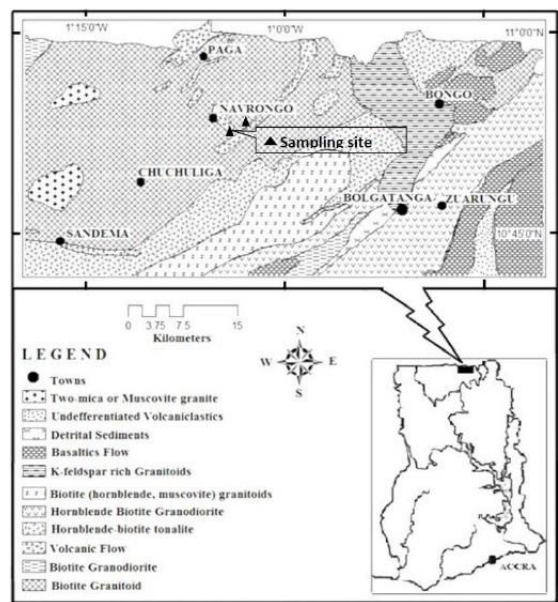
Figure 2: Geological map of the study area (After Foli et al.,